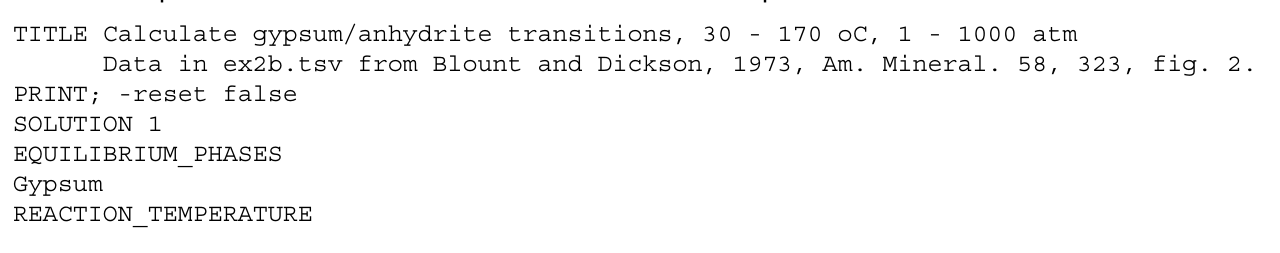
Table 14. Input file for the first and second simulation in example 2B.